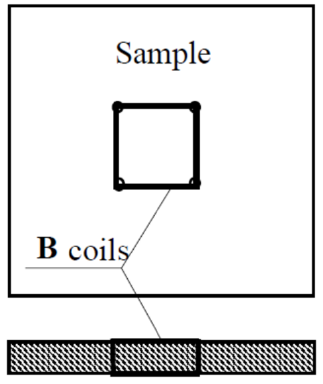
Figure 2. Arrangement of 2D B coils.